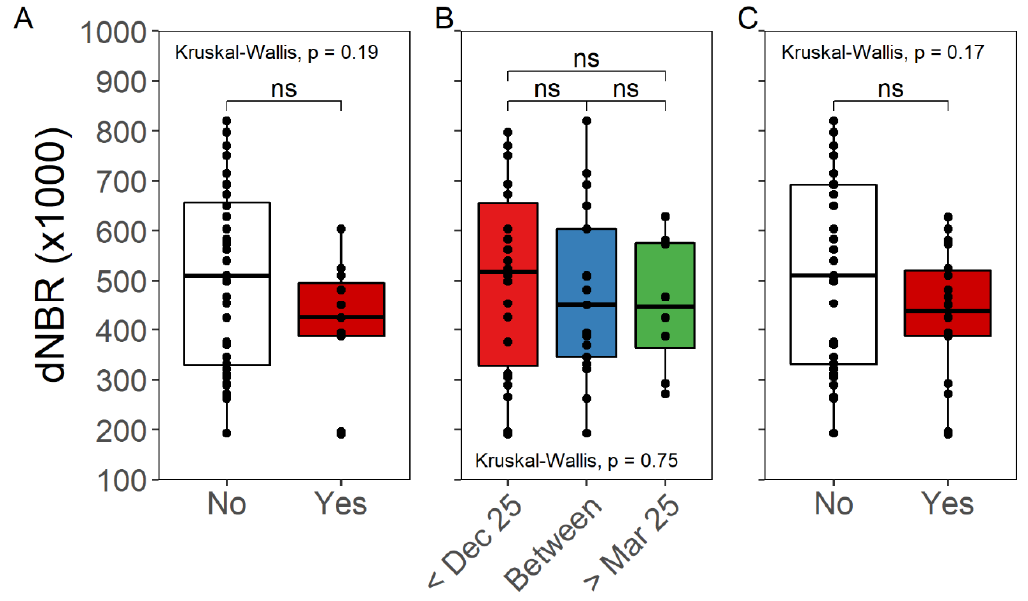
Figure A4. Influence of Landsat image time-series on dNBR . ( A ) Missing data: No = little to no influence of missing data on dNBR years. Yes = Notable portion of burn area impacted by missing data in dNBR years. ( B ) Fire dates [45]: < Dec 25 = fire dated before December 25 in fire season. > Mar 25 = fire dated after March 25 in fire season. Between = fire dated between December 25 and March 25 in fire season. Because image collection dates were December 25–March 25, the fires dated before these dates get a postNBR value soon after the burn while the fires dated after these dates get a post NBR value in the next year. The postNBR lag for fires dated during the image collection window depends on the medoid image that was selected over that area. ( C ) Combination: Yes = fires that either were impacted by missing data or are dated after March 25. These fires have the longest lag between burn date and postNBR date. No = all other fires.